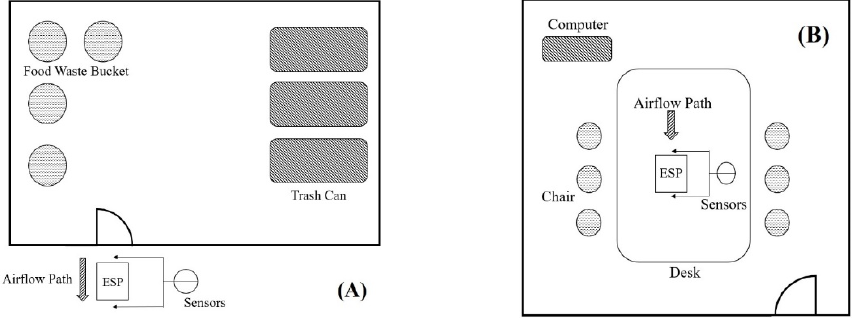
Table 2. Background of concentration in lab and field tests.